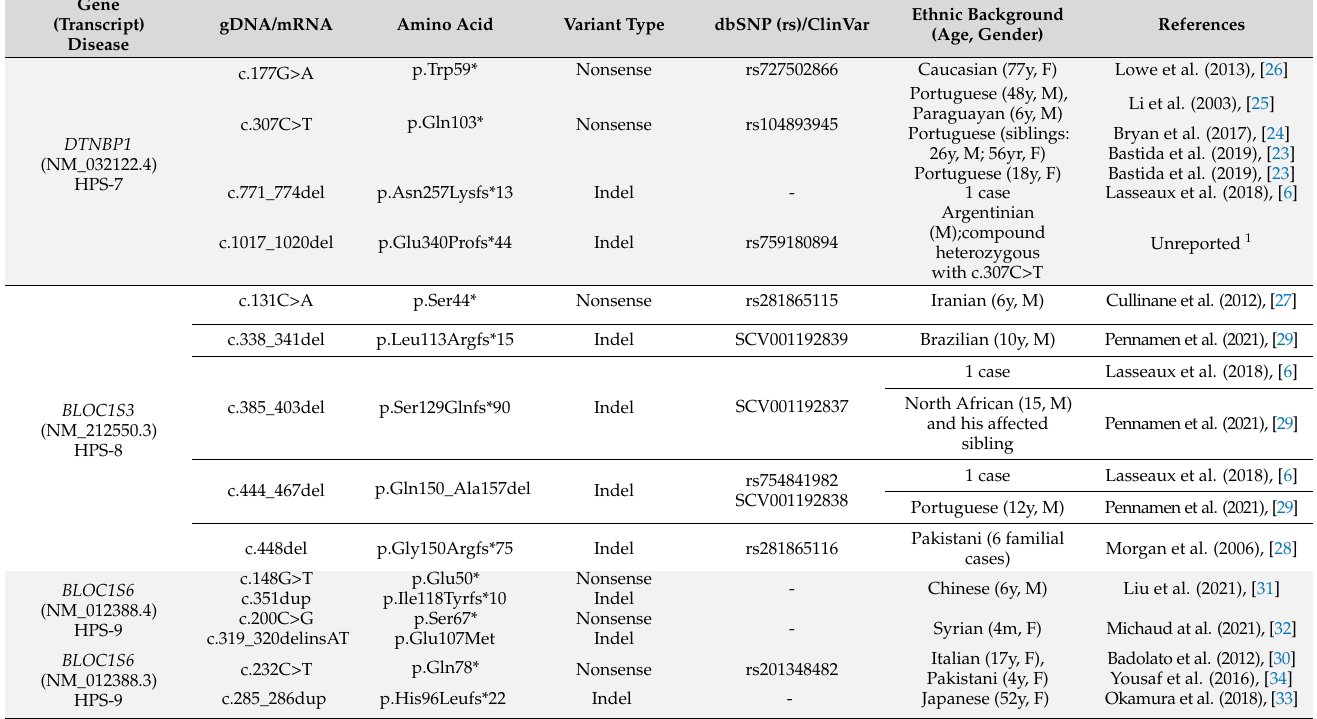
Table 2. Pathogenic variants identified in BLOC-1 genes associated with HPS type 7, 8, 9, and 11. Gene